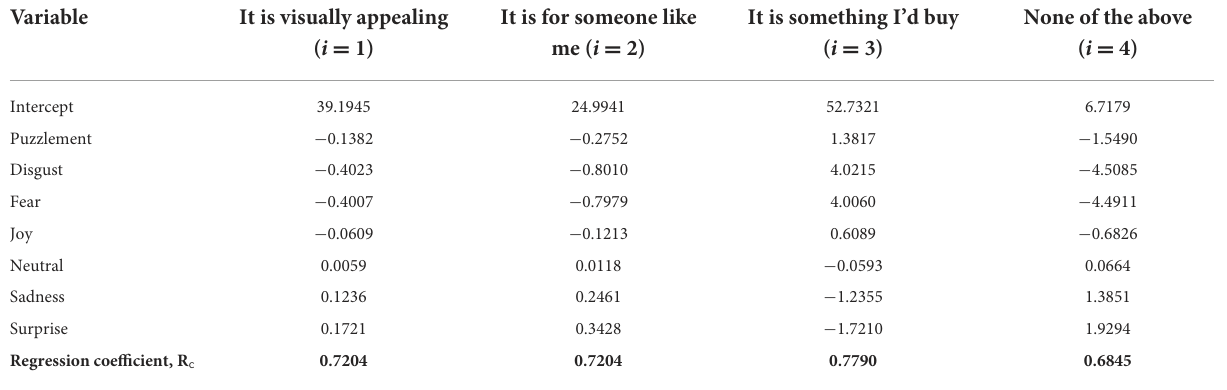
TABLE 5 Model parameters with the corresponding regression coefficient (R c ).